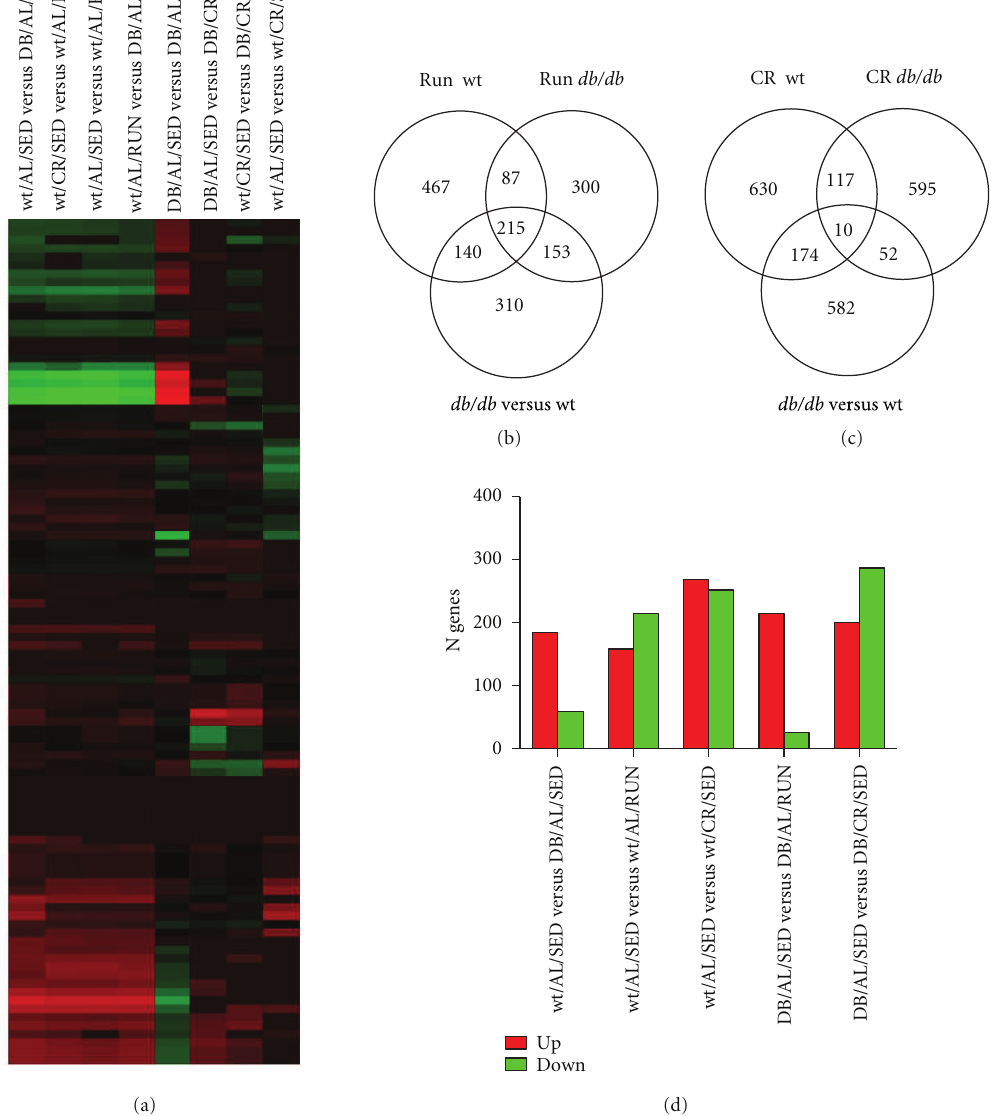
Figure 8: db/db and C57Bl/6 mice respond di ff erently to exercise and caloric restriction. (a) Heat map profiles showing that db/db and C57Bl/6 mice exhibit distinct transcriptional responses to energetic challenges. (b) Venn diagram showing the number of genes expressed following voluntary wheel running in C57Bl/6 and db/db mice. (c) Venn diagram showing the number of transcripts responsive to CR in C57Bl/6 and db/db mice. (d) Side-by-side comparison of the number of genes that di ff er between C57Bl/6 and db/db mice following running or